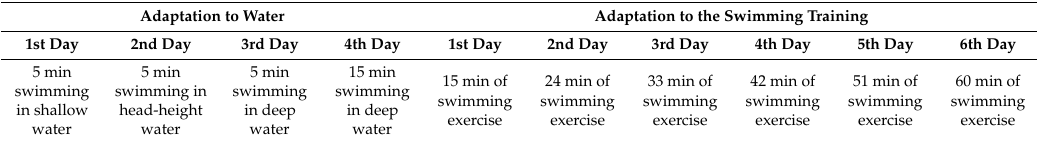
Figure 1. Schematic view of experimental procedure swimming training (ST); exposure to chronic mild stress (CS); exposure to chronic mild stress followed by swimming training (CS + ST); exposure to chronic mild stress followed by a recovery period (CS + R).